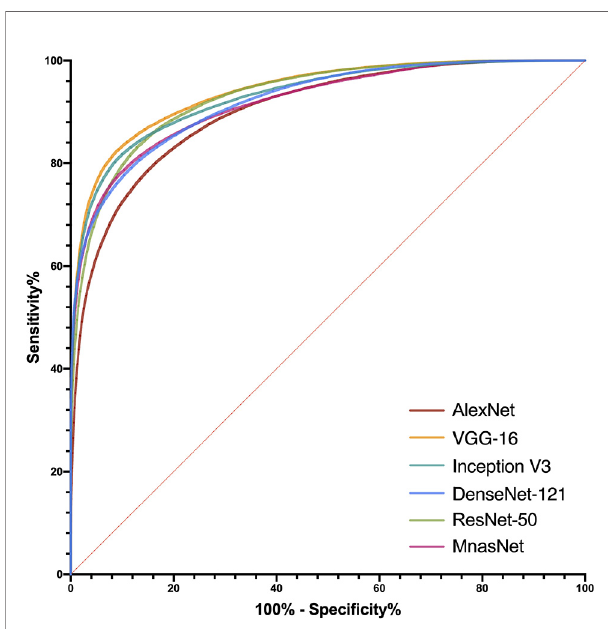
FIGURE 3 | Receiver operating characteristic curves in the patch-level binary classi fi cation of each